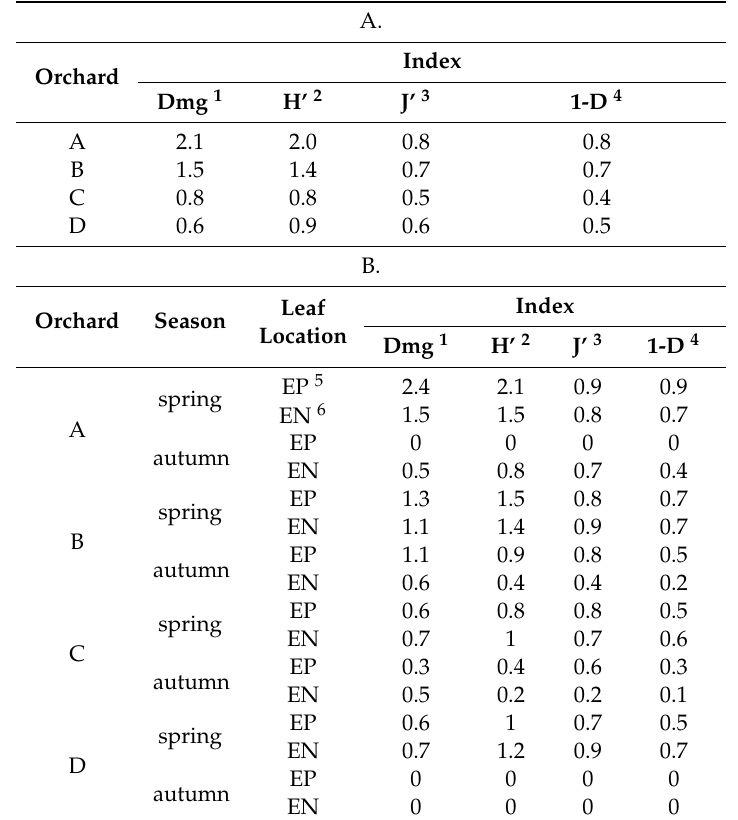
Table 2. Alpha diversity indexes from orchards ( A ) season and leaf location ( B ), obtained from the dataset matrix of fingerprinting generated by BOX-PCR of Psa strains isolated from the four kiwifruit orchards analyzed in this